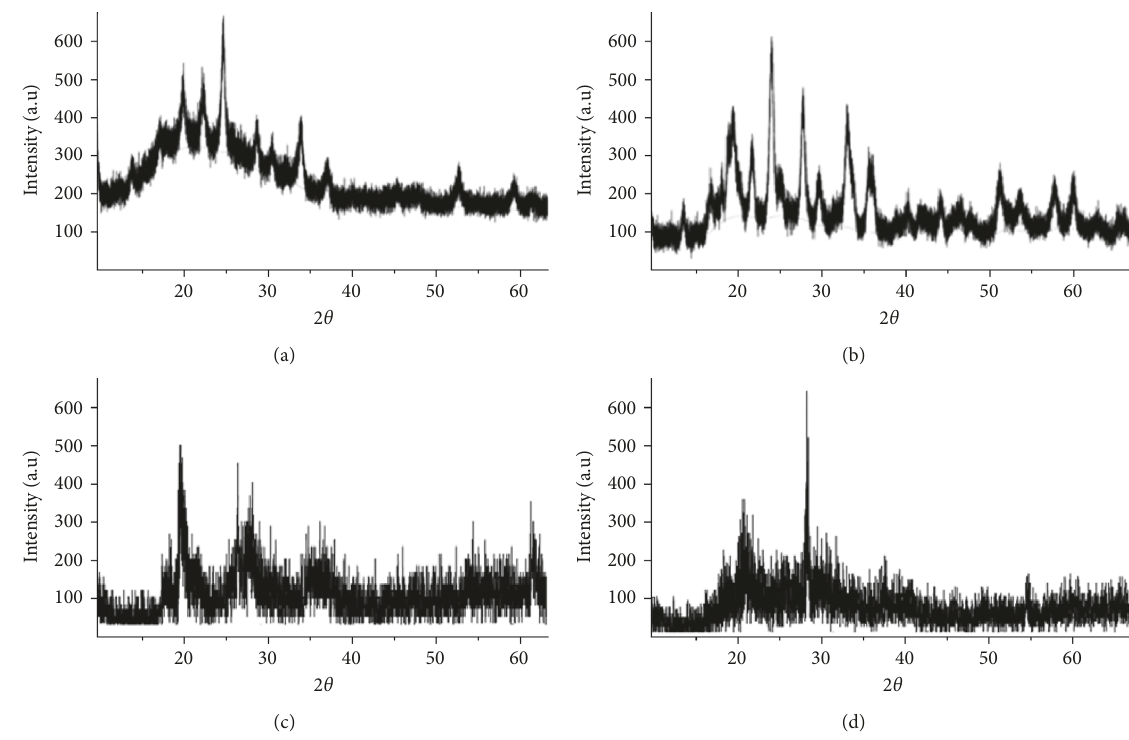
Figure 1: XRD diffractograms of (a) 25% HPW/SiO 2 (HPW-S), (b) 25% HPW/kaolinite (HPW-K), (c) 25% HPW/bentonite (HPW-B), and (d) 25% HPW/montmorillonite